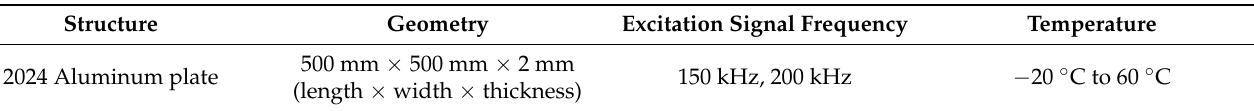
Table 2. Working condition of LW propagation simulation under temperature